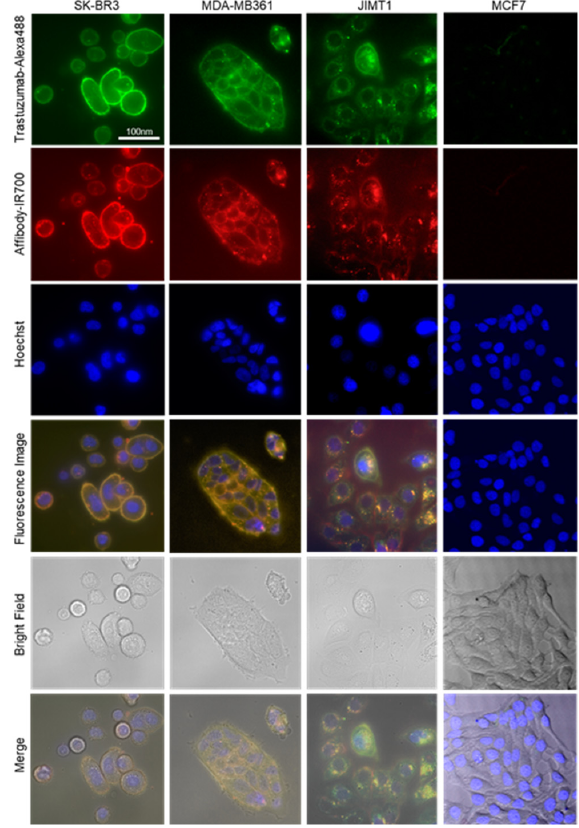
Figure 3. Fluorescence images of the cells show HER2-specific localization of HER2 Affibody- IR700Dye conjugate and trastuzumab-Alexa488 conjugate in HER2-positive cells (SK-BR3, MDA- MB361, and JIMT1) but not HER2-negative cells (MCF7).